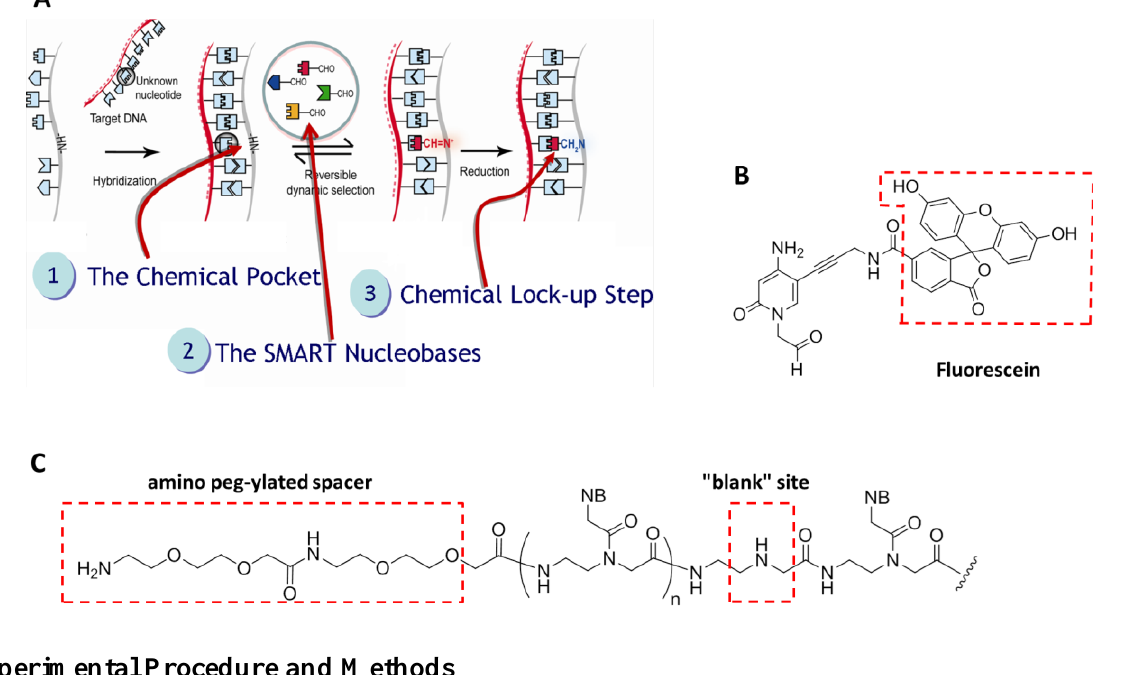
Figure 2. ( A ) The steps involved in DestiNA Genomics chemical-based approach